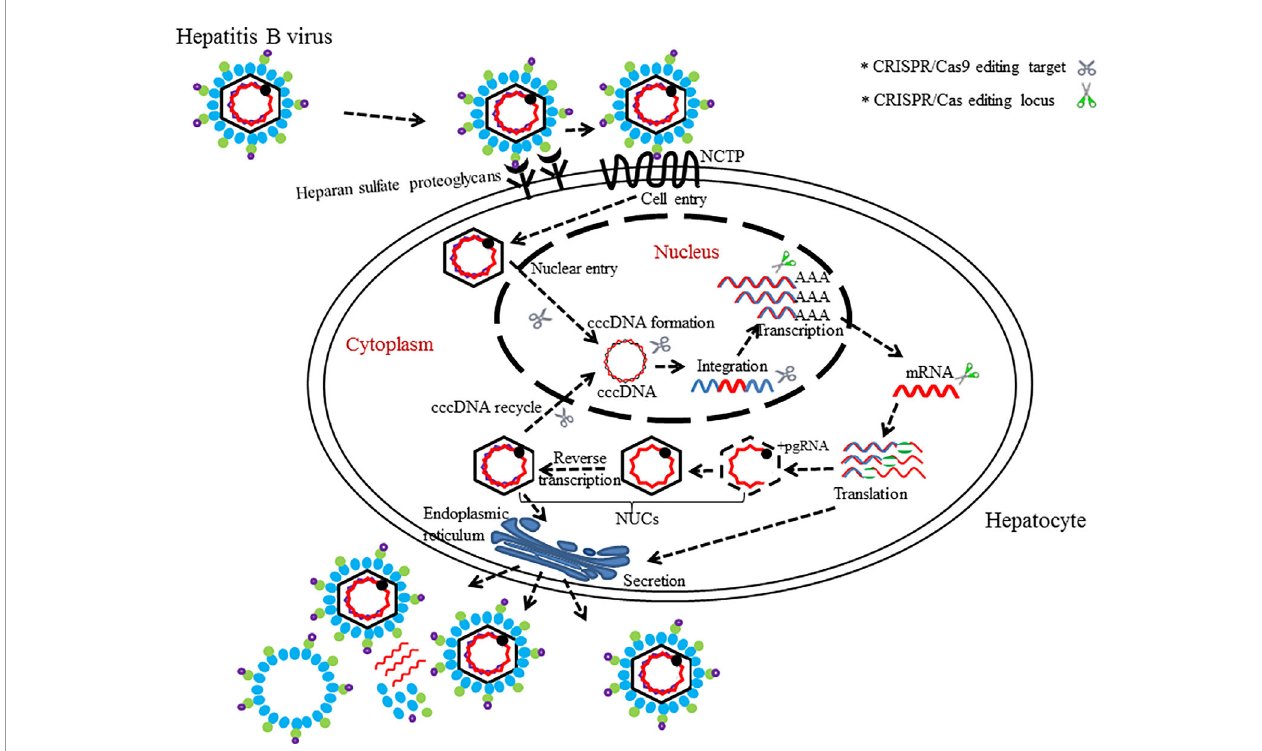
FIGURE 3 | The life cycle of HBV with editing targets. HBV binds to surface receptors and enters the hepatocytes. Virus particle complete its process of growth and proliferation in host ’ s hepatocytes. CRISPR/Cas (or CRISPR/Cas9)-mediated disruption of the HBV life cycle can target several loci, which is necessary for the HBV life